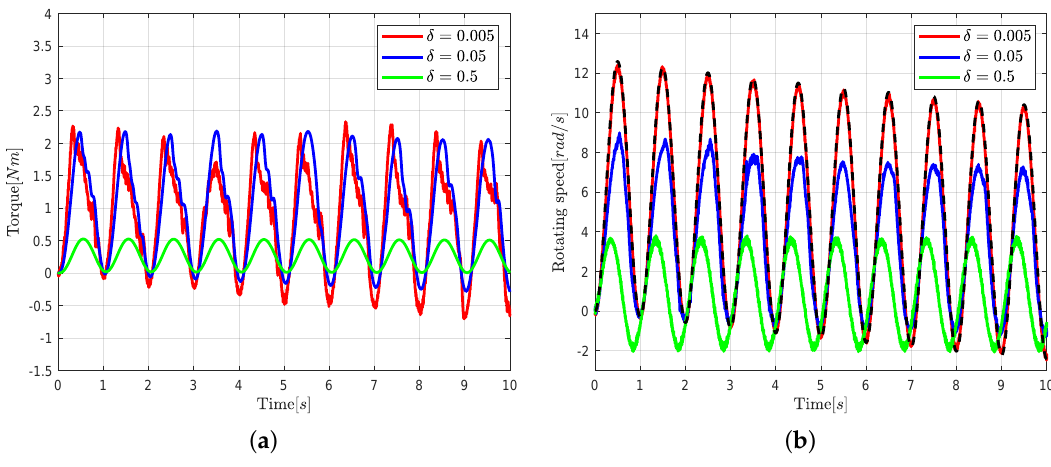
Figure 7. The responses with various design parameters δ : T m = sin ( 2 π t ) Nm. ( a ) The measurement of the dynamometer torque T e . ( b ) The measurement of the rotating speed ω m (solid), and the desired one ω em (dashed) obtained by numerical